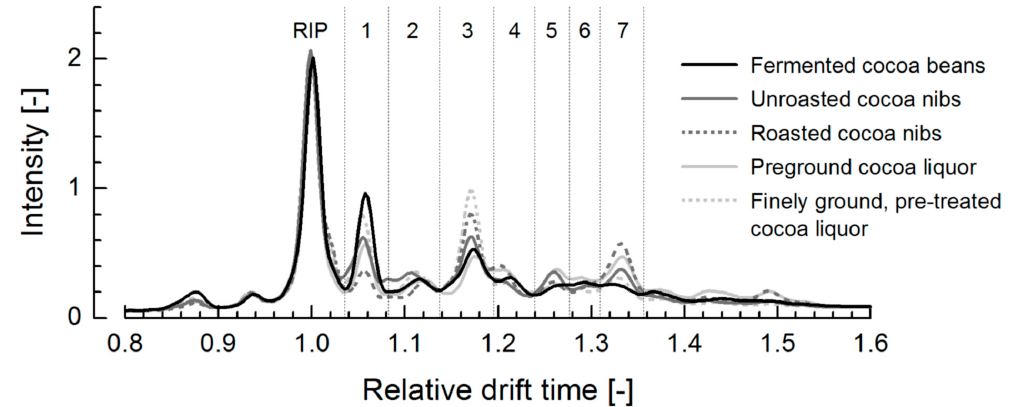
Figure 3. IM spectra of bulk cocoa ( n = 3).